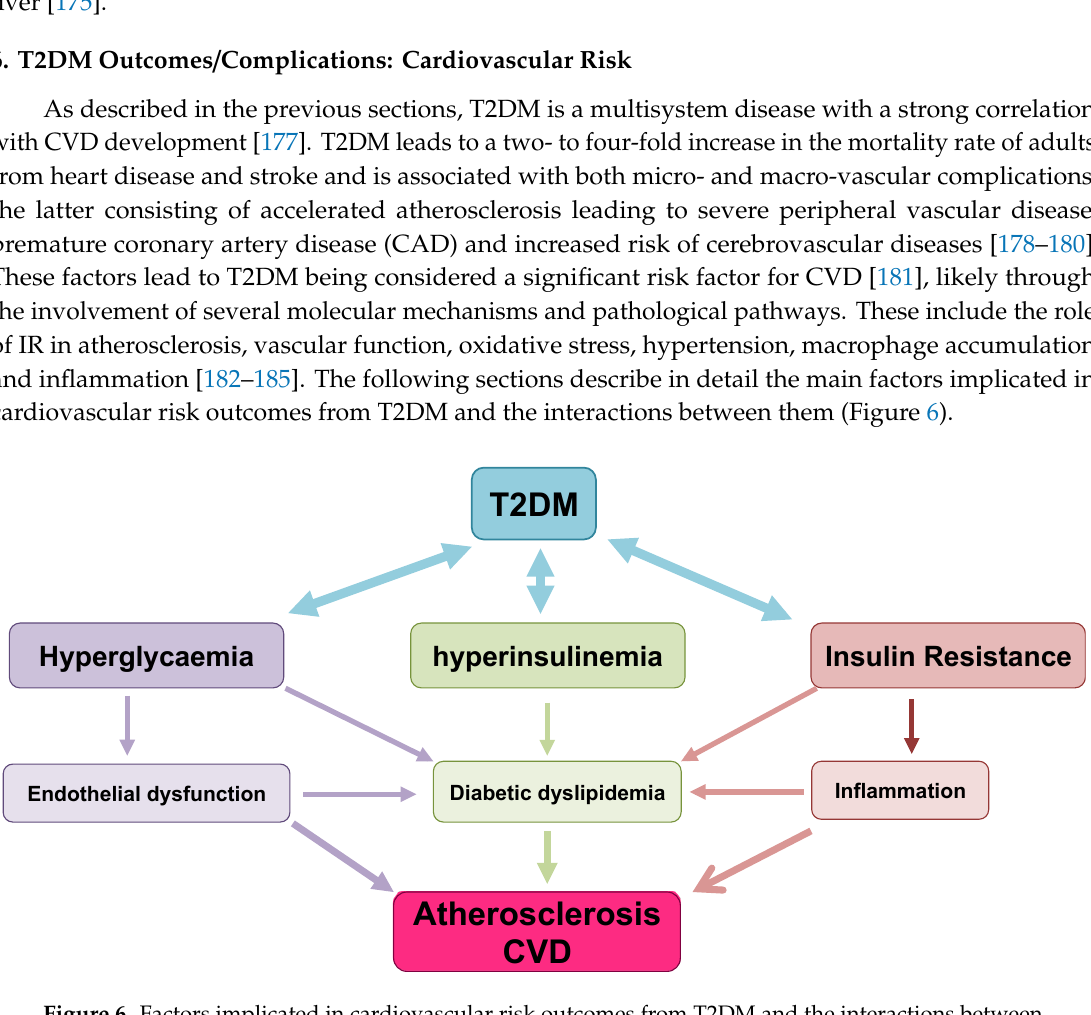
Figure 6 . Factors implicated in cardiovascular risk outcomes from T2DM and the interactions between them. T2DM derived hyperglycemia, hyperinsulinemia and IR causes endothelial dysfunction, diabetic dyslipidemia and inflammation leading to CVD. The flowchart illustrates the multiple interactions among the implicated factors.